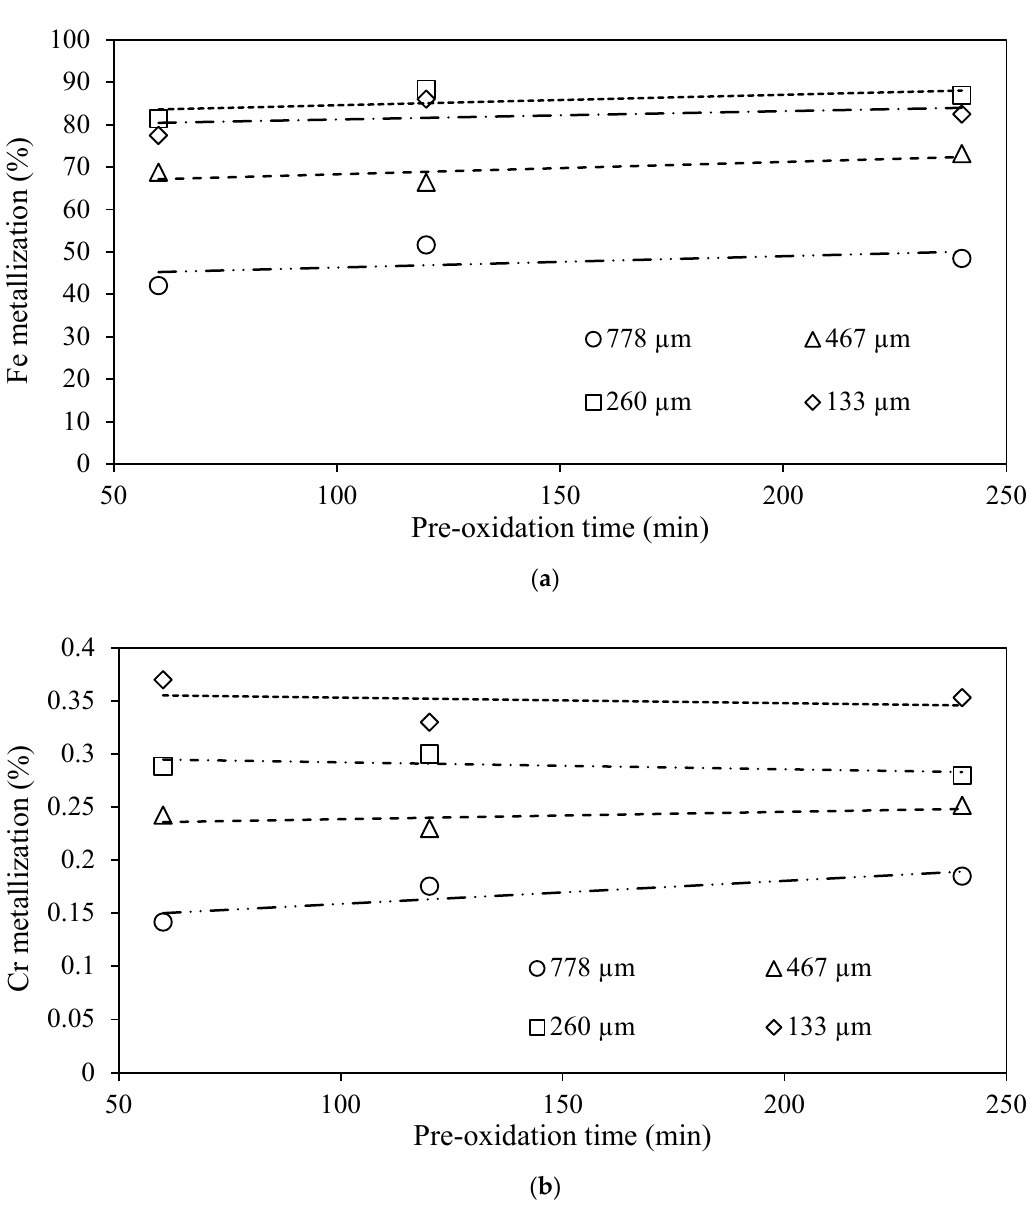
Figure 12. The effect of pre-oxidation time on Fe ( a ) and Cr ( b ) metallization. Size-fractioned samples were pre-oxidized at 1100 °C for 60, 120, and 240 min and subsequently reduced at 1100 °C for 60 min at a hydrogen flow rate of 750 mL/min.